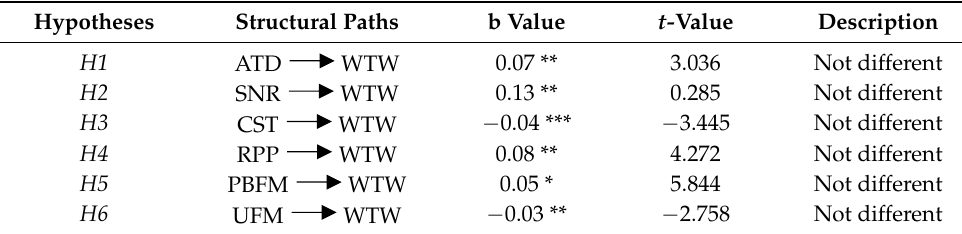
Table 7. Goodness-of-fit indices results.